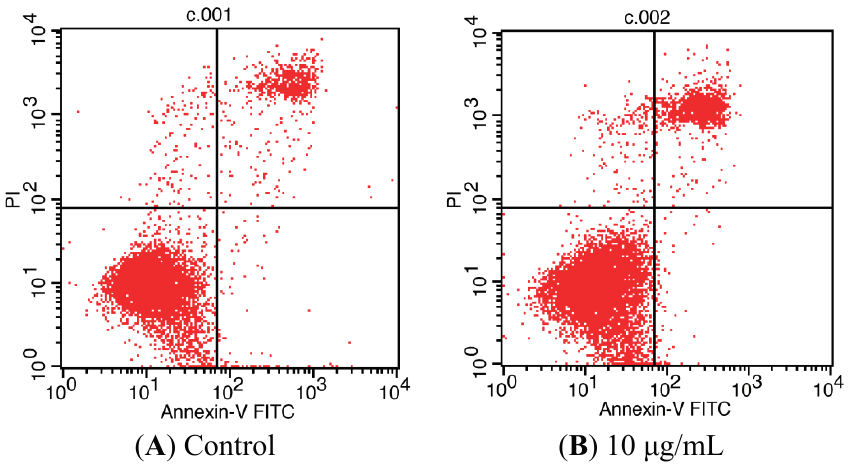
Figure 4. Tatariside G-induced apoptosis of HeLa cells was discriminated by AV and PI double staining. Following 24 h of treatment with tatariside G, the cells were labeled with AV and PI and analyzed by flow cytometry. The lower left quadrant shows vital cells (double negative) and the lower right quadrant indicates early apoptotic cells (AV positive but PI negative). The upper right quadrant represents late apoptotic cells (double positive). ( A )–( D ) Typical images. ( E ) Average apoptosis rate of cells in each group. ** p < 0.01 vs. the control group. Data are expressed as the mean ± SD. n =